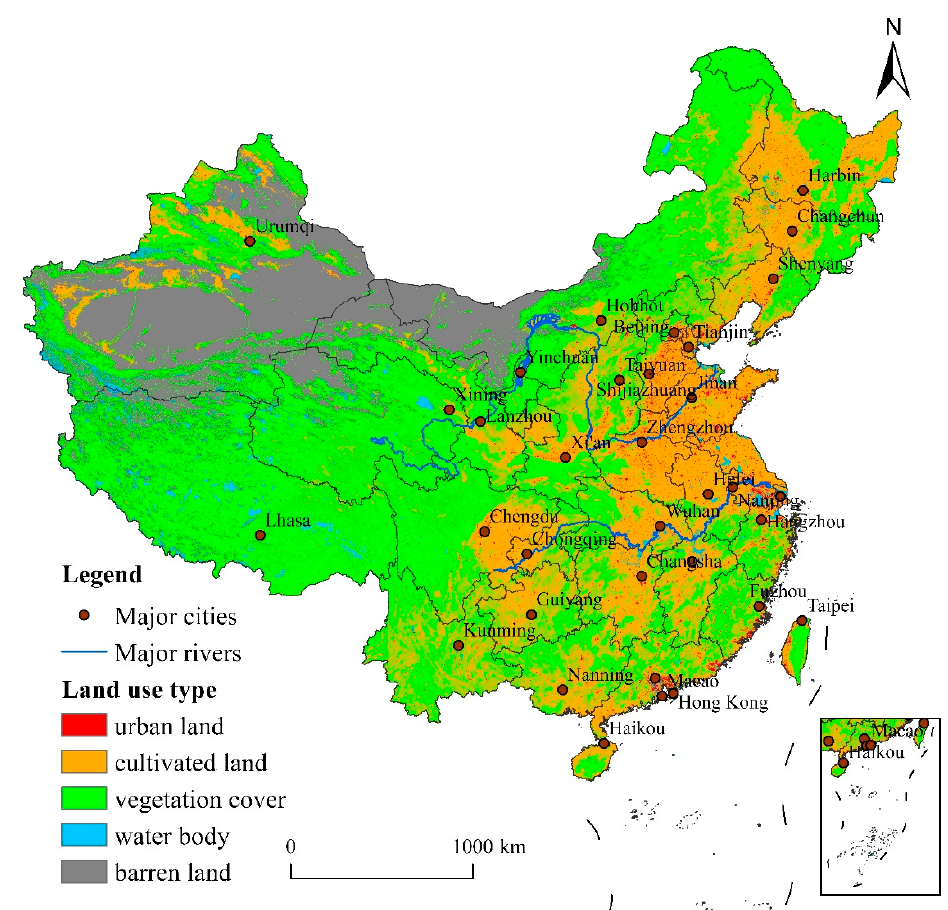
Figure 2. The distribution of land use in China (2019).